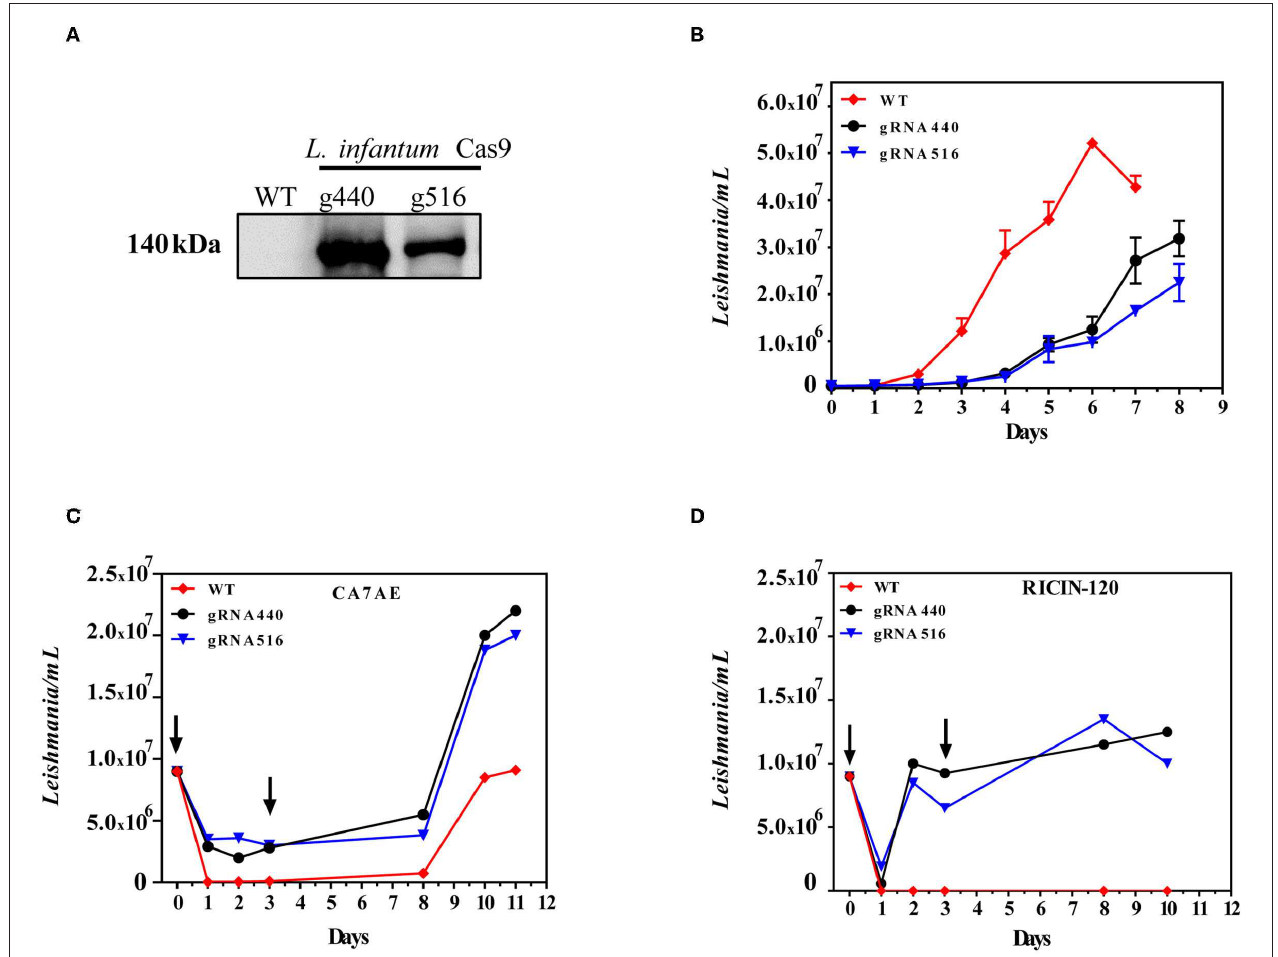
FIGURE 2 | Generation of LPG2 knockout using CRISPR/Cas9. (A) Western blot analysis of L. infantum promastigotes expressing Cas9 (gRNA440 and gRNA516). (B) Growth curves of L. infantum wild-type (WT) and L. infantum -Cas9 (gRNA440 and gRNA516) promastigotes. (C) Agglutination assay using the CA7AE monoclonal antibody and associated growth curves. (D) Agglutination assay using Ricin 120 lectin and associated growth curves, demonstrating the selection of 1 lpg2 . The arrows indicate the time points where antibody (CA7AE) or lectin (Ricin-120) were added to the cultures, exemplifying the typical agglutination results